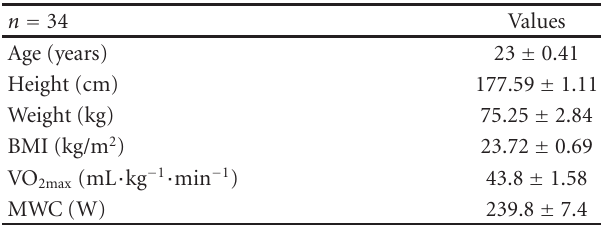
Table 1: Age, height, weight, body mass index (BMI), and ergo- metric parameters: maximal oxygen consumption (VO 2max ) and maximal working capacity (MWC) during resting time. Results are means ± SE of the 34 male healthy